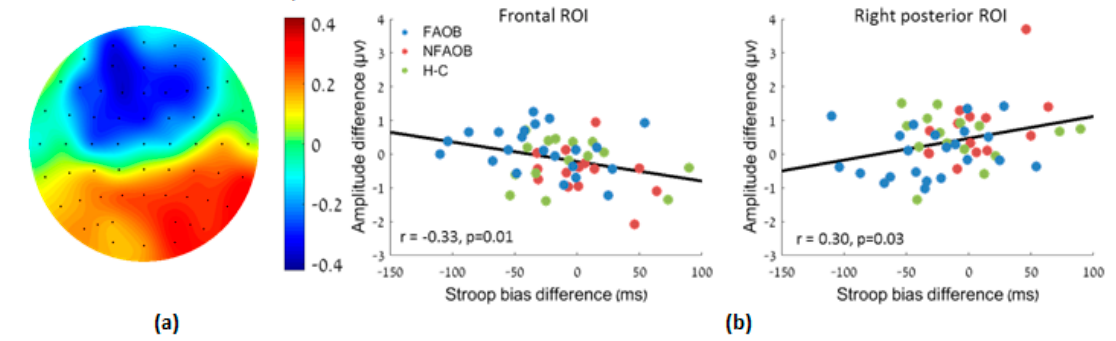
Figure 5. Association between the amplitude change and the Stroop bias change following HCF compared to NF images, for the participants altogether. ( a ) A topographic plot of the linear correlation magnitude between the food-cue induced LPPb amplitude and the Stroop bias changes. ( b ) Scatter plots of the same in the frontal and right posterior ROI. HCF: high-calorie food. NF: nonfood. LPP: late positive potential. ROI: region of interest.